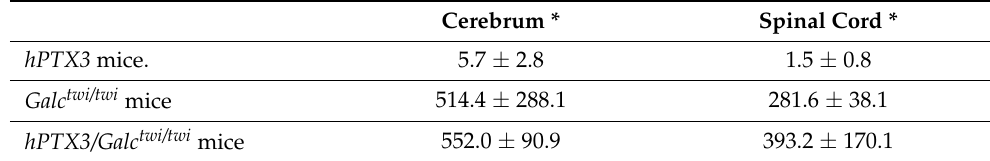
Table 2. Psychosine levels in the CNS of GALC-deficient mice.